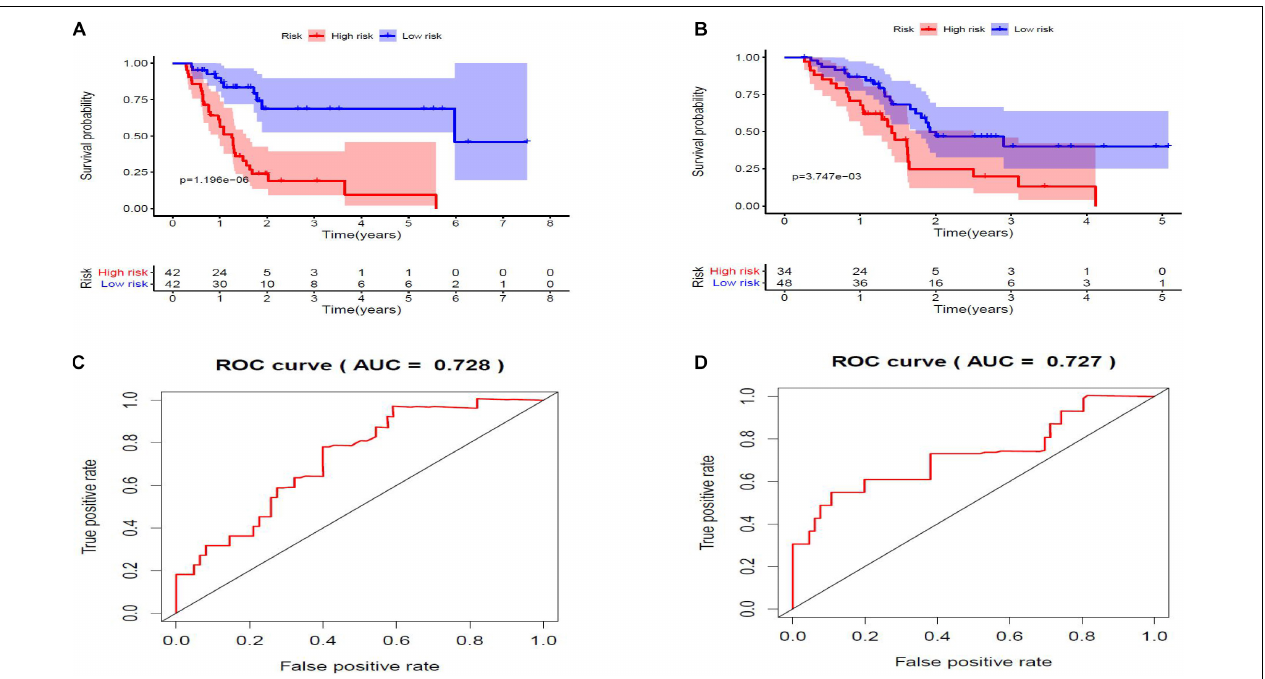
FIGURE 6 | (A,B) Kaplan–Meier survival curves. Low-risk score subgroup and high-risk score subgroup are highlighted by blue curve and red curve, respectively. The cutoff value of risk score is determined by its median value. Panels (A,B) are modeling cohort ( p = 1.196e-06) and validation cohort ( p = 3.747e-03), respectively. (C,D) Receiver operating characteristic (ROC) curves. X - and Y -axes represent false-positive rate and true-positive rate, respectively. Area under curve (AUC) value of modeling cohort and validation cohort are 0.728 and 0.727,